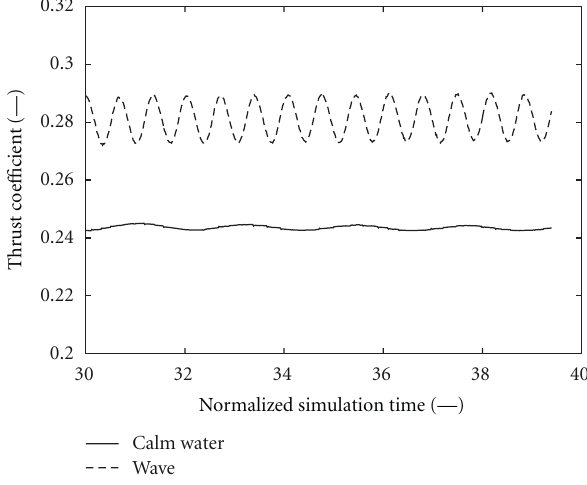
Figure 21: Comparison of the computed thrust coe ffi cient ( T/ ( ρn 2 D 4 )) during the last part of the